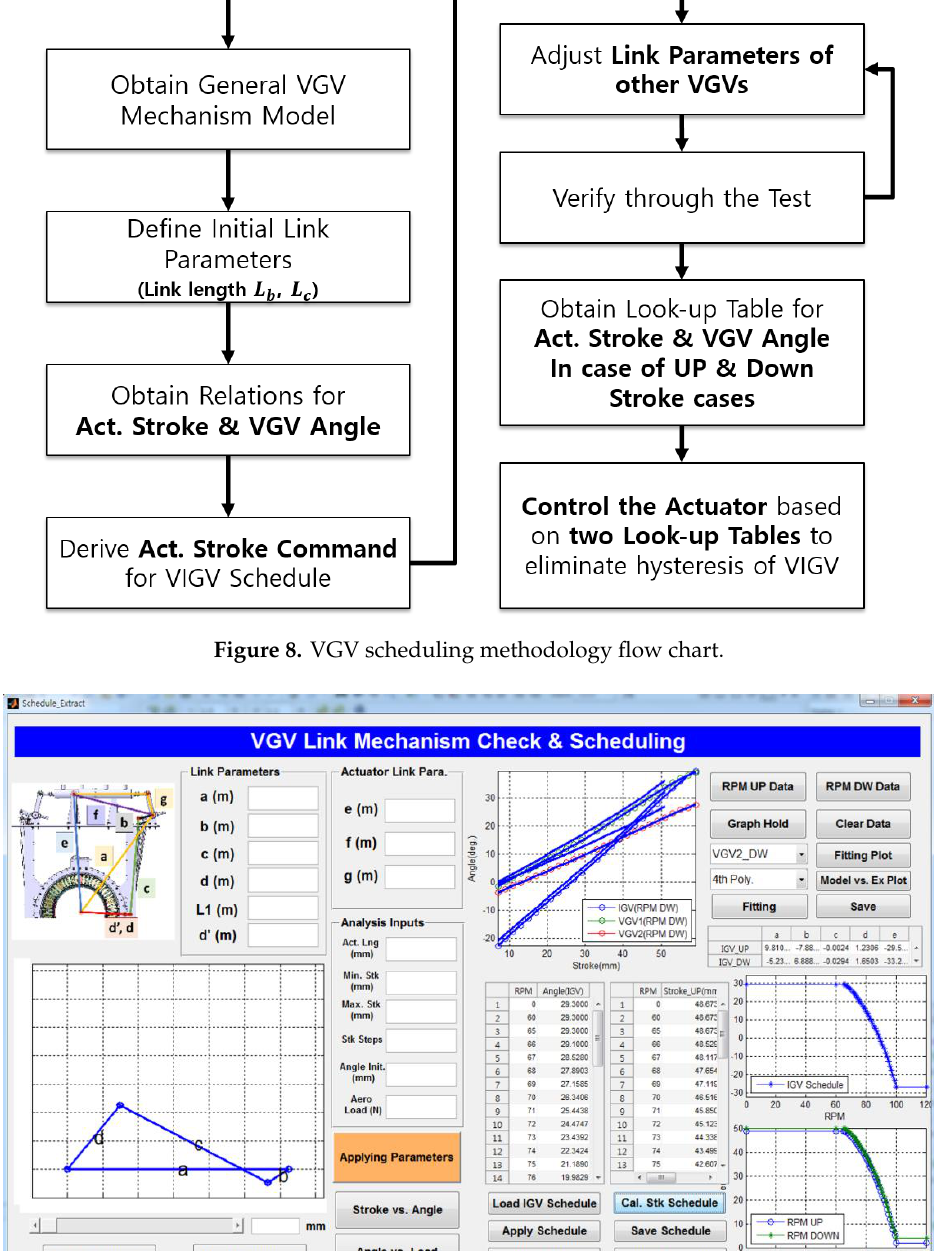
Figure 9. In-House software for scheduling VGVs.